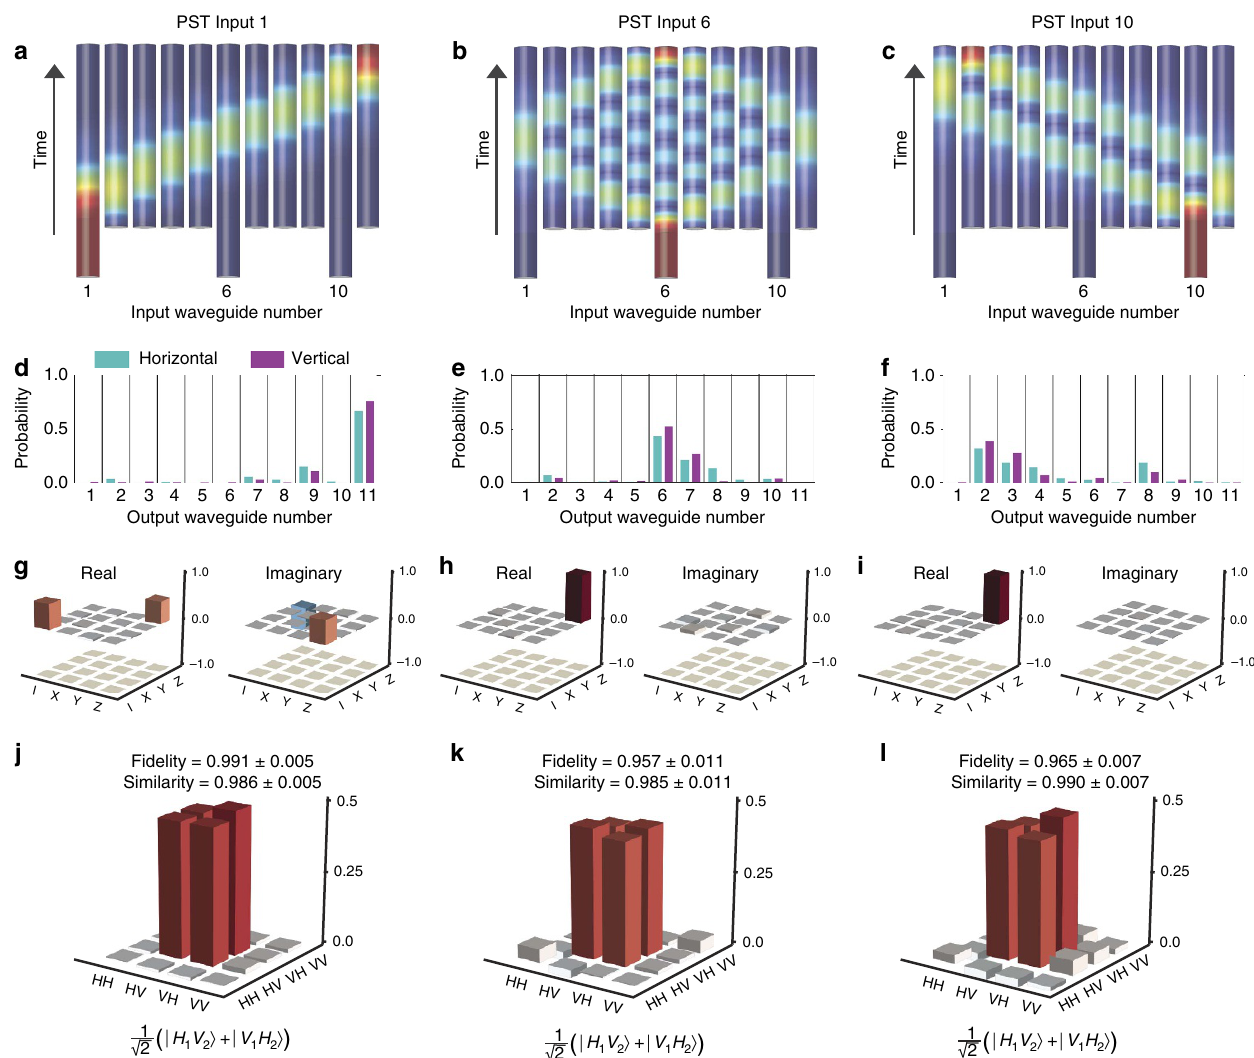
Figure 3 | Experimental data from the characterization and performance of perfect state transfer waveguide array. ( a – c ) Propagation simulations showing the device implementation to enable specific waveguide input. ( d – f ) Output probability distributions for each input of the PSTarray for horizontally and vertically polarized laser light. ( g – i ) Quantum process matrix for each transfer in the PST array measured with single-photon quantum process tomography. ( j – l ) Two-photon quantum state tomography is performed after photon 1 of the polarization entangled Bell state 1 ffiffi relocated. Results have had the small imaginary components removed for